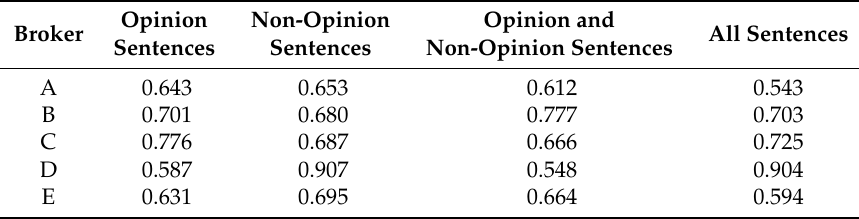
Table 4. Summary by broker in forecasting analyst net income estimates with our method. Macro-F1 is a measure.